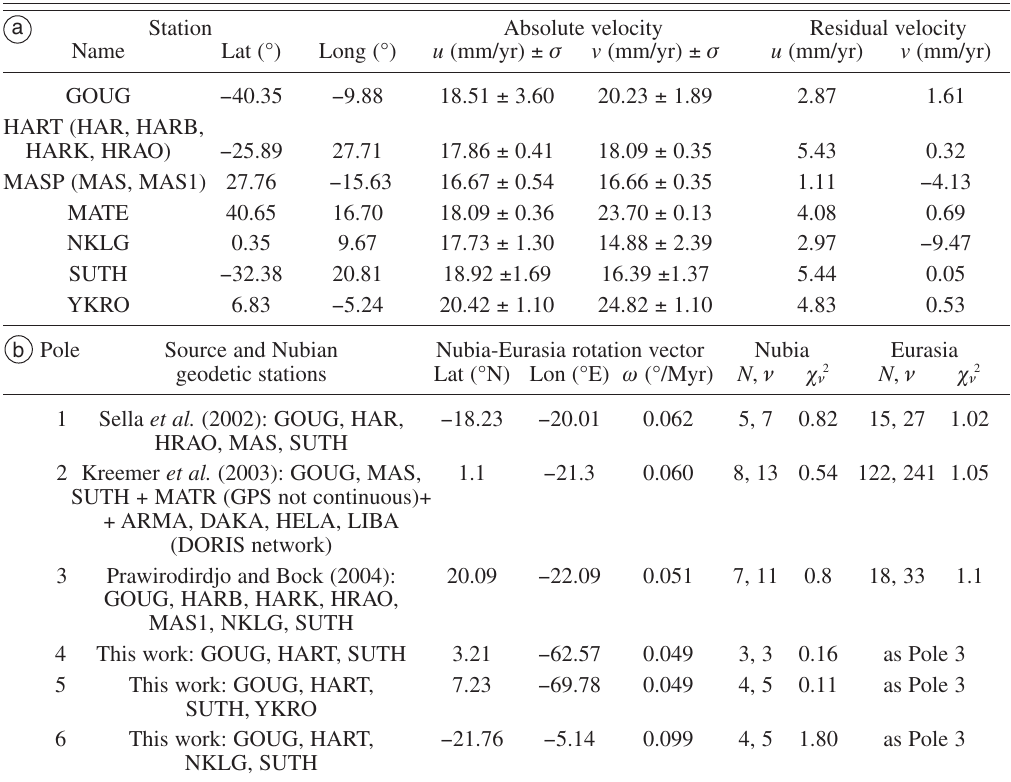
Table IIIa,b. Nubia-Eurasia kinematics from geodetic measurements. a) North (u) and east (v) components of absolute and residual velocity in 7 GPS continuous stations located in Nubia and in the Southern Adriatic (MATE), shown in fig. 5. Absolute velocities and standard deviations ( σ ), are provided by the Laboratoire de Recherches en Géodésie (LAREG), whose ITRF2000 solution is available at <http://lareg.ensg.ign.fr>. Resid- ual velocities are obtained from absolute ones by subtracting Prawirodirdjo and Bock’s (2004) Eurasia absolute pole (latitude 57.246°N, longitude − 99.691°E and angular velocity 0.260°/Myr). b) Nubia-Eurasia Euler poles (fig. 5) taken from literature (1, 2 and 3) and determined in this work (4, 5 and 6) by the data set reported in a). All the above Nubia-Eurasia Euler poles have been obtained by difference from the related Nubia and Eurasia absolute poles (see text for explanations). For each case, the list of continuous GPS stations used to constrain the Nubia absolute pole is shown. Pole 2 has also been constrained by 1 non-continuous GPS site and 4 sites be- longing to the DORIS network ( e.g. , Willis et al. , 2005). The columns «Nubia» and «Eurasia» report basic in- formation about the absolute Euler poles from which the above Nubia-Eurasia poles derive. N is the number